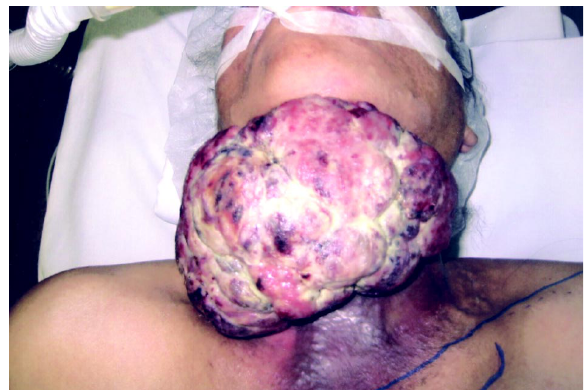
Figure 1 – Large anterior cervical